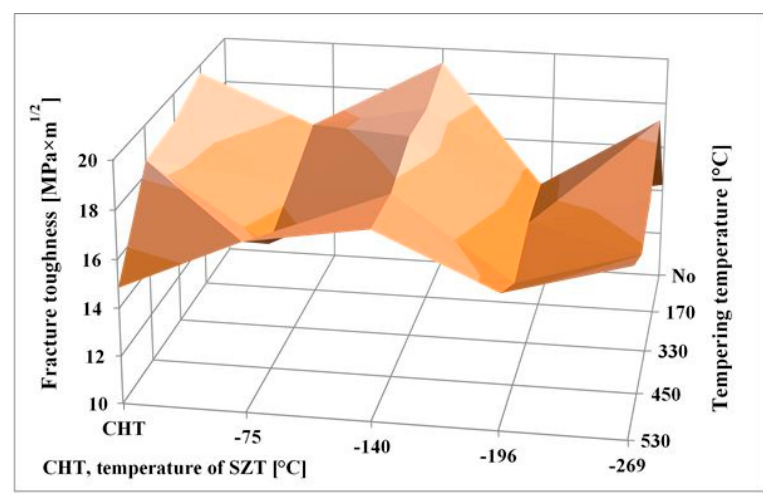
Figure 14. Comparison of the obtained fracture toughness values for differently sub-zero treated and tempered specimens made of the Vanadis 6 steel.